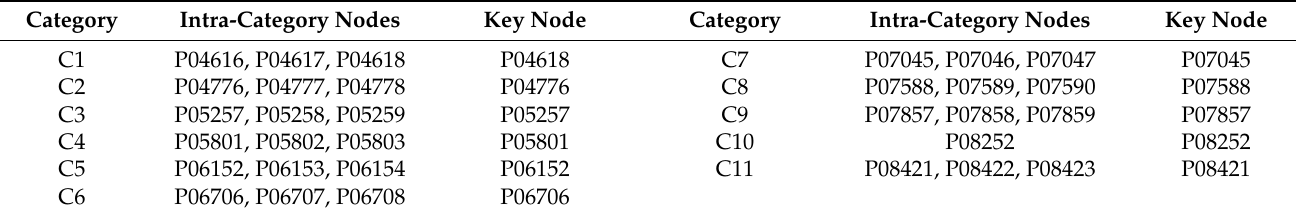
P04618 (displacement), P04776 (stress), and P07588 (stress) for example. The three key nodes each presented in 2017 a time sequence curve as shown in Figure 8. The three curves are vastly different in amplitude of variation and volatility.